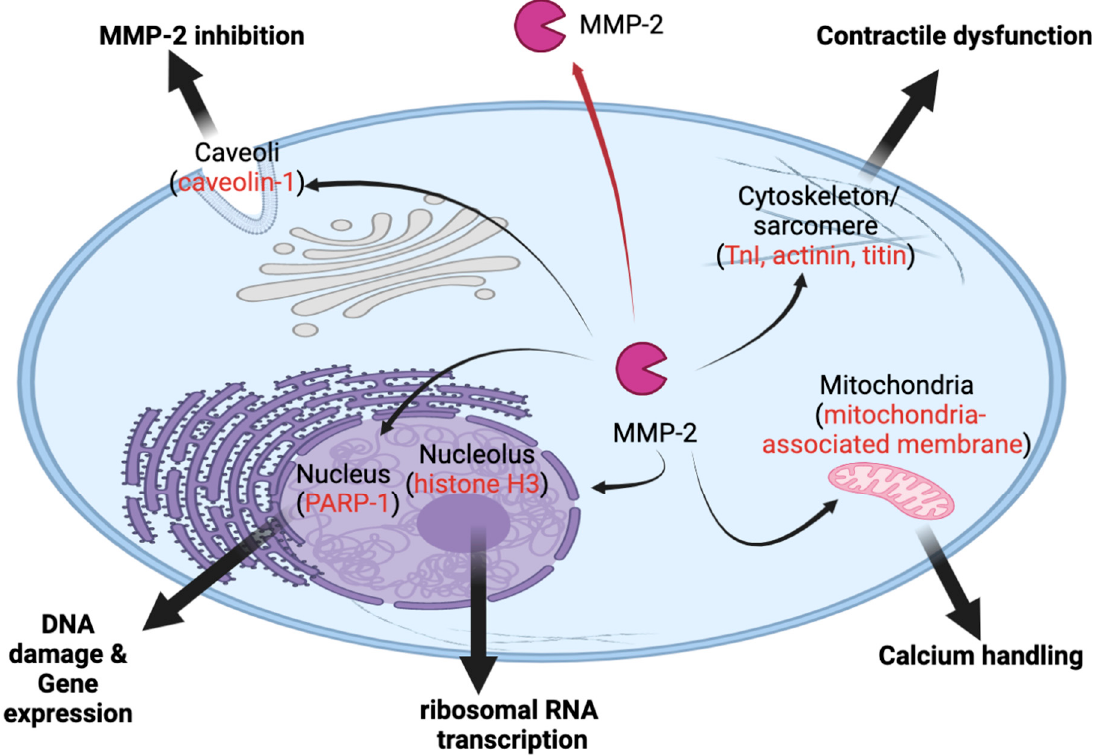
Figure 3. MMP-2 was first described as a secreted protease; however, MMP-2 is localized to prominent subcellular locales and functions at these locations. The red arrow indicates the canonical trafficking of MMP-2 outside the cell. Black arrows indicate new intracellular locales of MMP-2 to caveola, sarcomere, cytoskeleton, mitochondria, nucleolus, and nucleus. In red, potential substrates or partners of MMP-2 are listed in these locations.